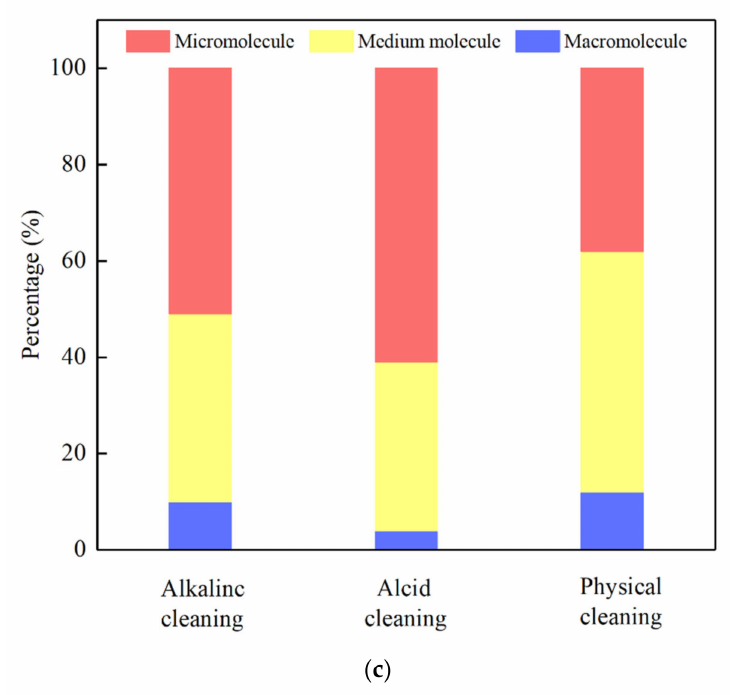
Figure 7. The MW of the membrane elution: ( a ) direct UF; ( b ) L-UF; and ( c )